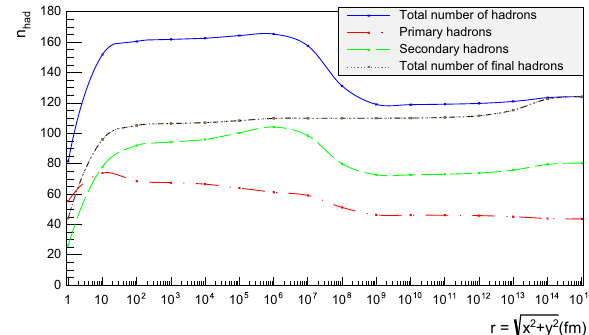
Fig. 21 Hadron number per event as a function or radius for 13 TeV pp collisions